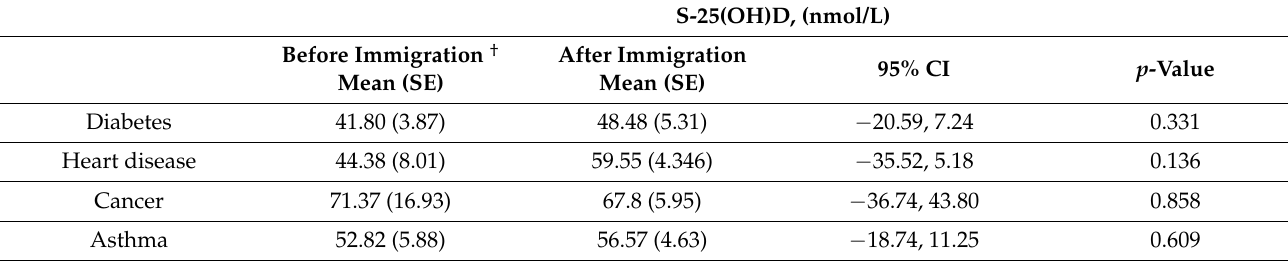
Table 4. Weighted mean 25(OH)D (nmol/L) based on the time of diagnosis (before or after immigration).